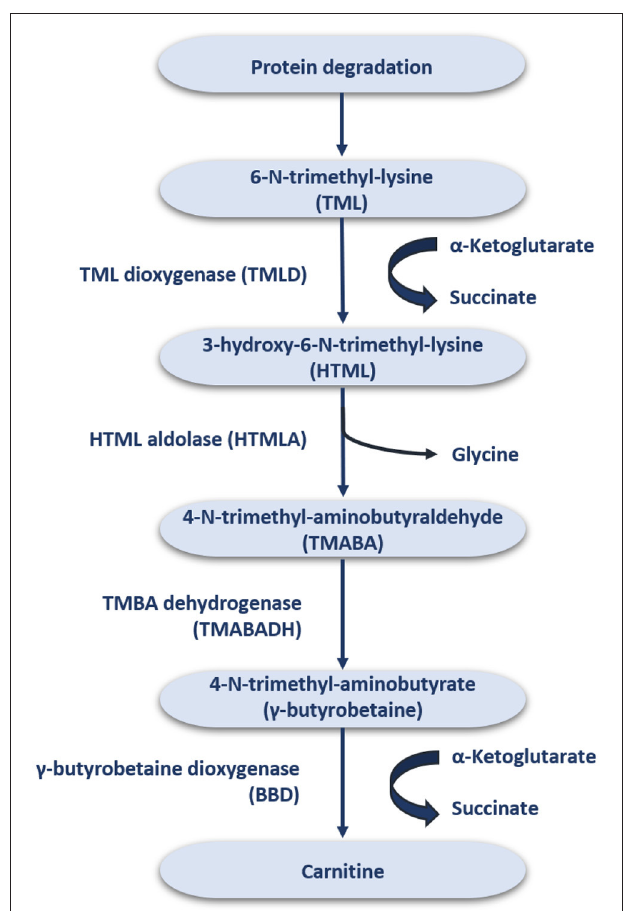
FIGURE 1 | The endogenous synthesis of